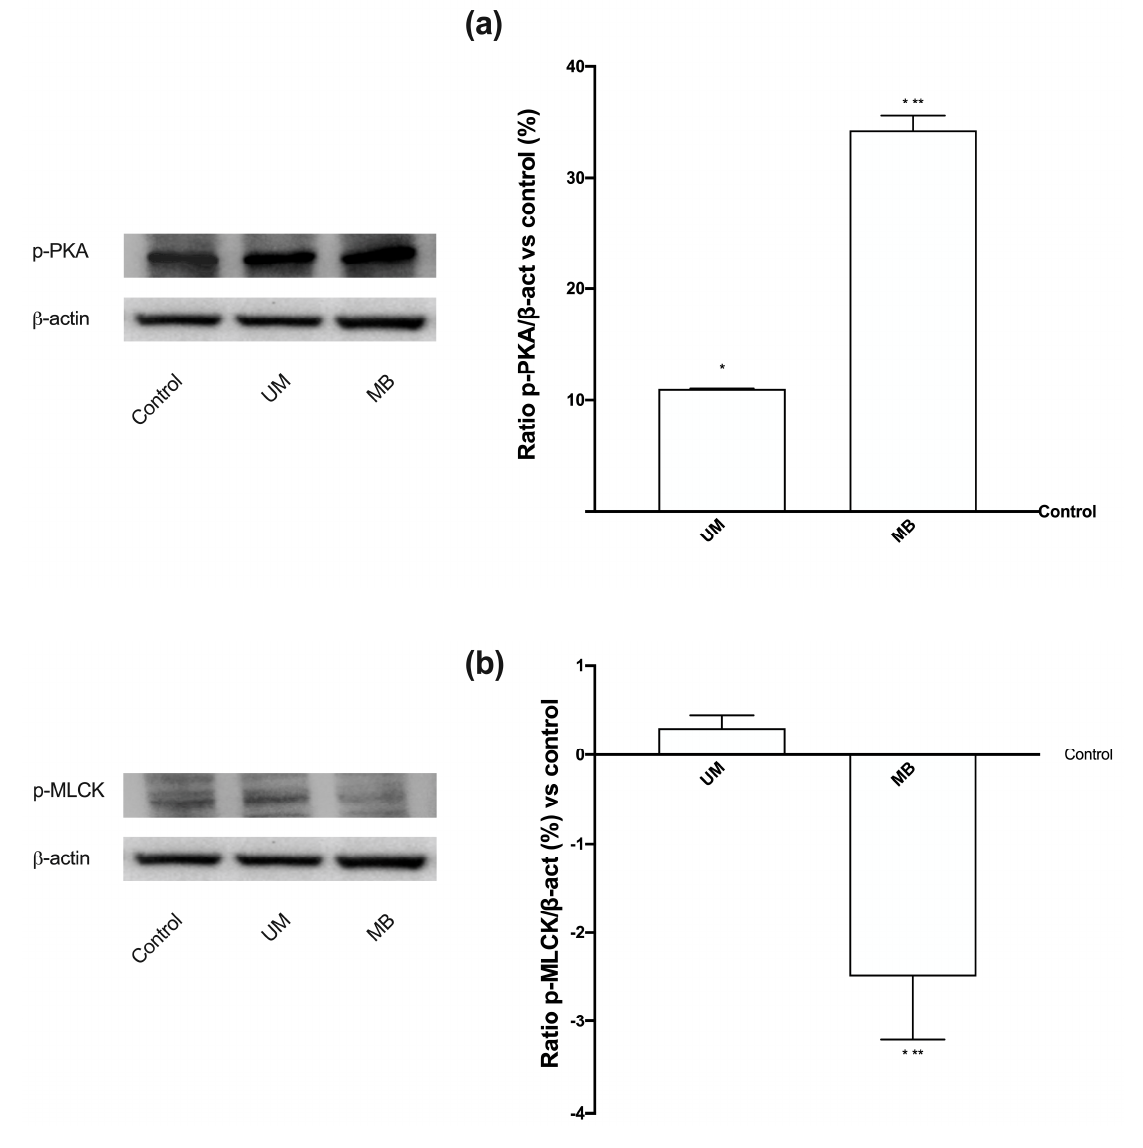
Figure 8. Western blot and densitometric analysis of PKA and phospho-myosin light chain (MLCK) on PHN1-41 cells. Western blot and densitometric analysis of PKA ( a ) and p-MLCK ( b ), analyzed on whole PHN1-41 lysates at 3 h of stimulations. The images reported are an example of each protein from five independent experiments reproduced in triplicate. Data are expressed as means ± SD (%) of five independent experiments normalized and verified on β -actin detection. * p < 0.05 vs. control; ** p < 0.05 vs. UM. The abbreviations are the same as reported in Figure 1.